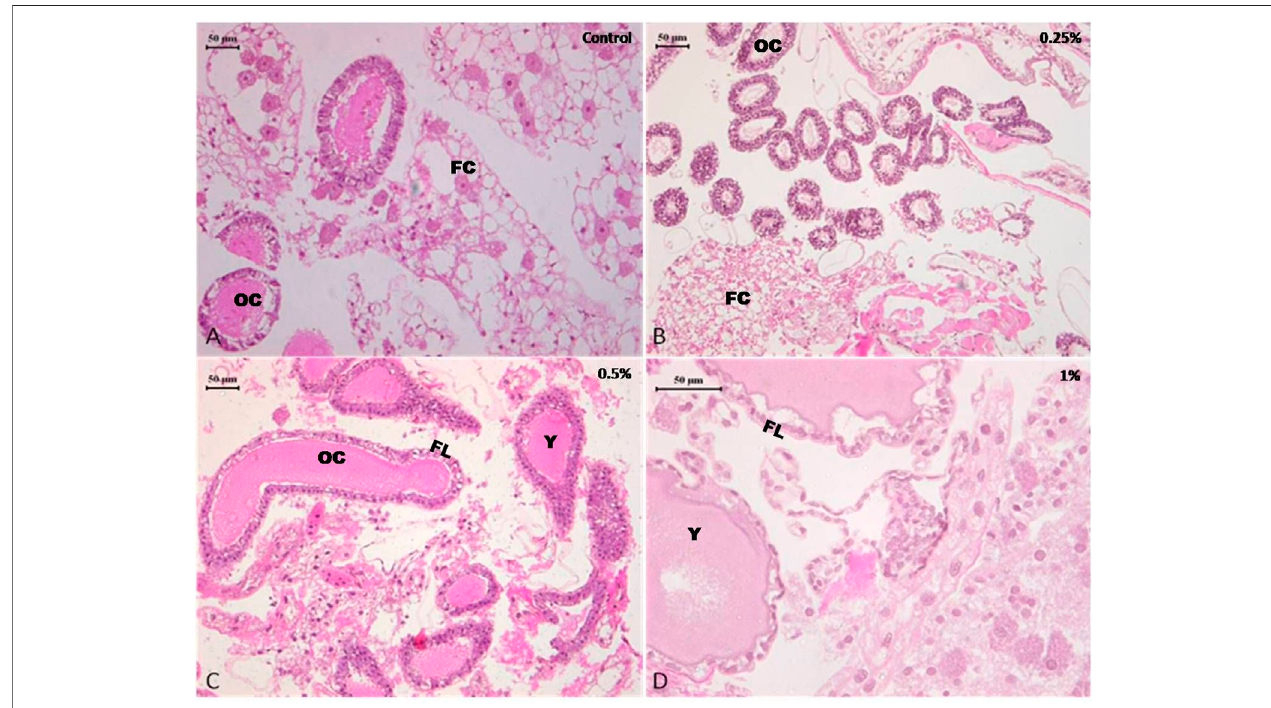
FIGURE 3 | Photomicrograph of control and deltamethrin treated cockroach ( P. americana ) ovary: (A) Control; (B) treated with 0.25% deltamethrin; (C) treated with 0.5% deltamethrin; (D) treated with 1% deltamethrin. FC, fat cells; OC, oocytes; FL, follicular cells; Y, yolk granules.